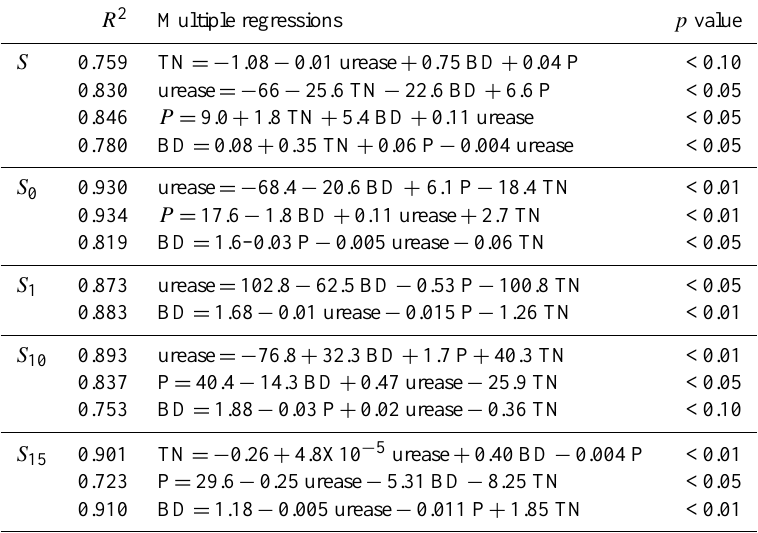
Table 4. Coefficient of determination and multiple regressions of the minimum data set (MDS)